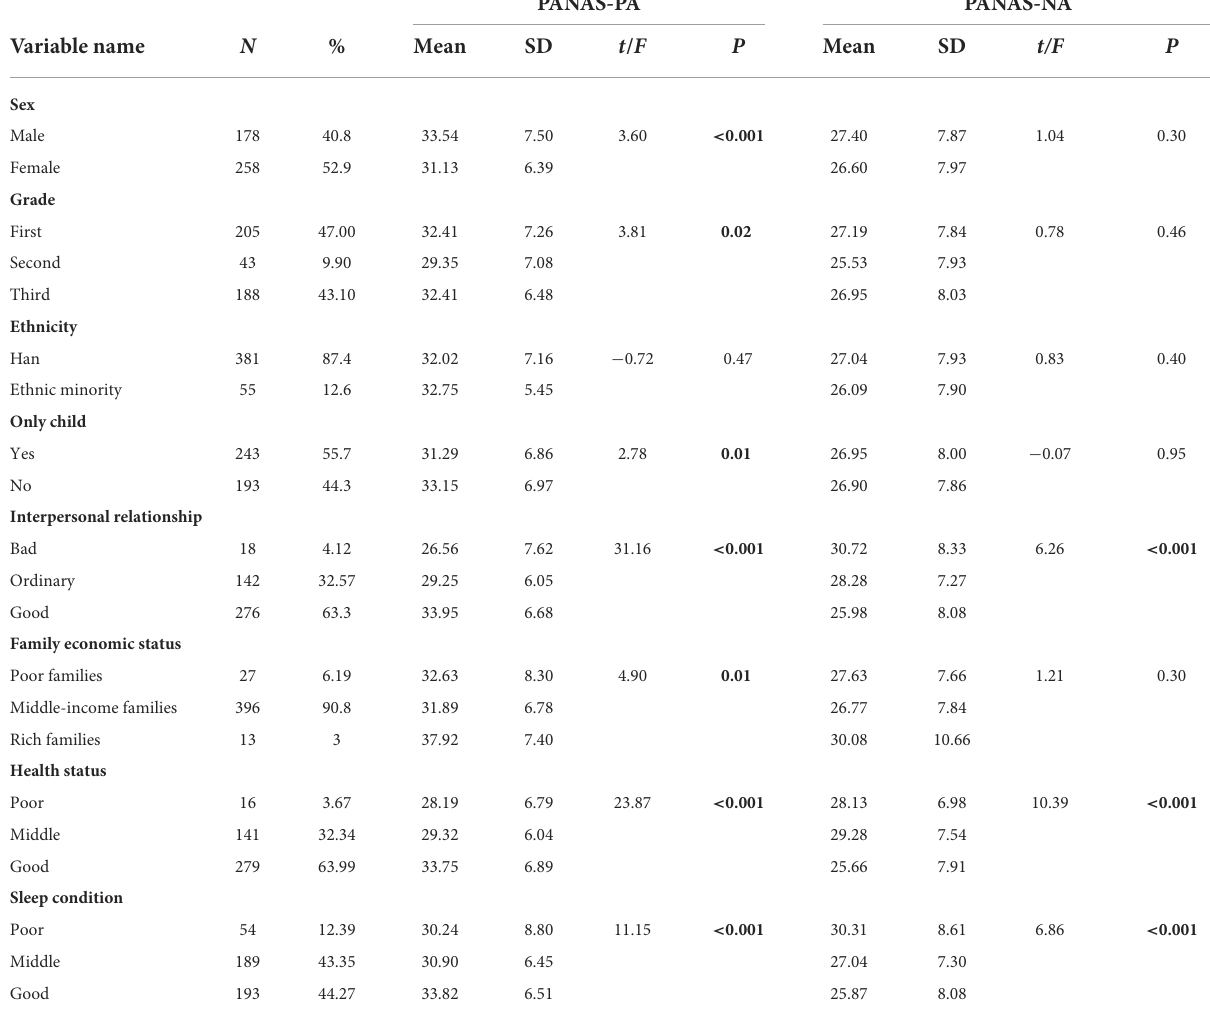
TABLE 1 Demographic characteristics of the study sample ( n = 436). PANAS-PA